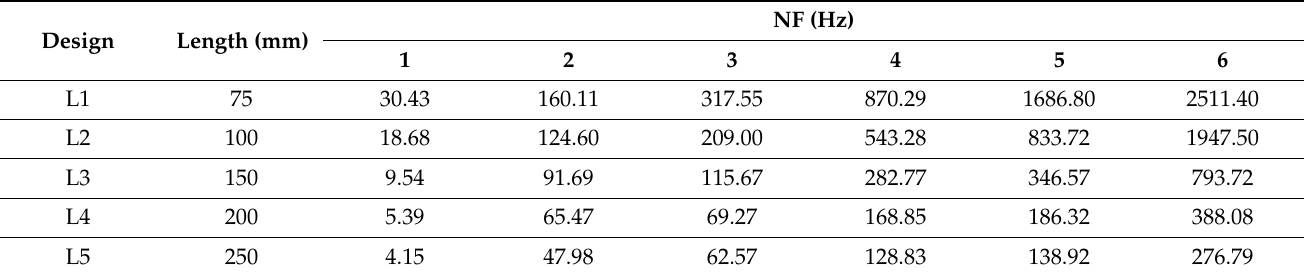
Table 3. First six NF of main cantilever beam with varying length (width = 20